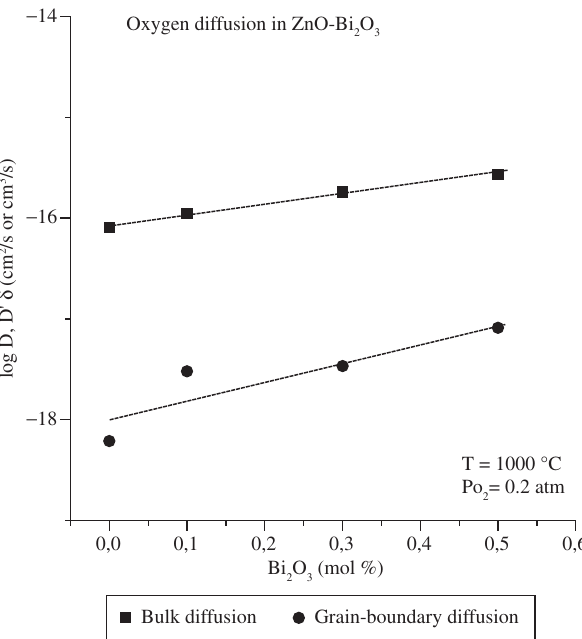
Figure 5. Effect of the Bi